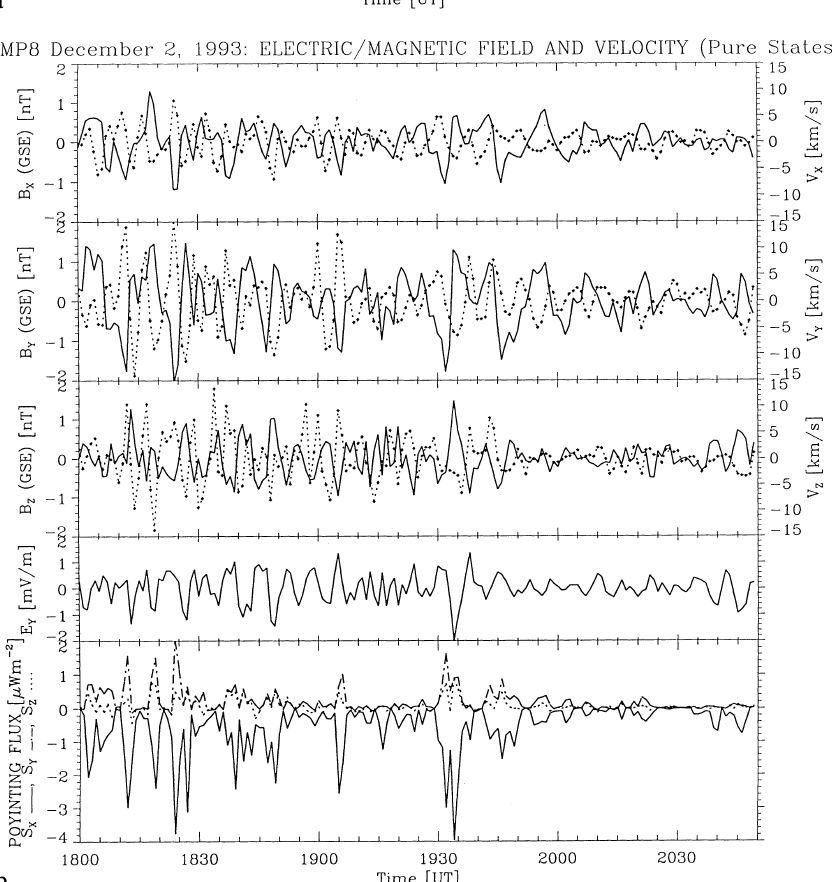
Fig. 3. The IMP-8 15-s interplanetary magnetic field and 1-min plasma mea- surements demonstrating the presence of Alfve´ n waves. b The pure state filtered 1-min IMF, solar wind velocity and inferred dawn-dusk electric field. Low frequency oscillations are attenuated by a 10-min detrender. Also, the wave Poyn- ting flux is shown ( bottom